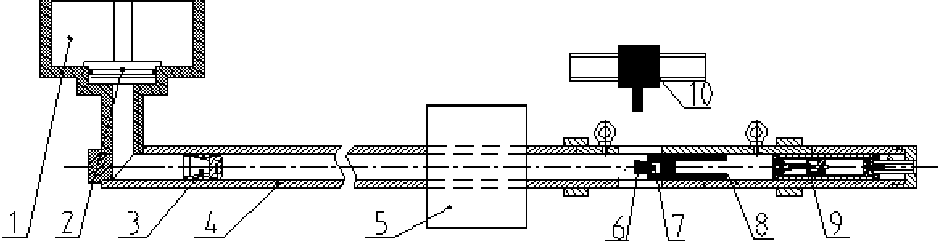
Figure 5. Schematic diagram of the quasi-static calibration system. (1) High-pressure gas chamber; (2) valve; (3) projectile; (4) launching tube; (5) silencer; (6) collision object (sensor mounting base); (7) calibrated accelerometer; (8) guiding cylinder; (9) liquid gas buffer device; and (10) laser interferometer.